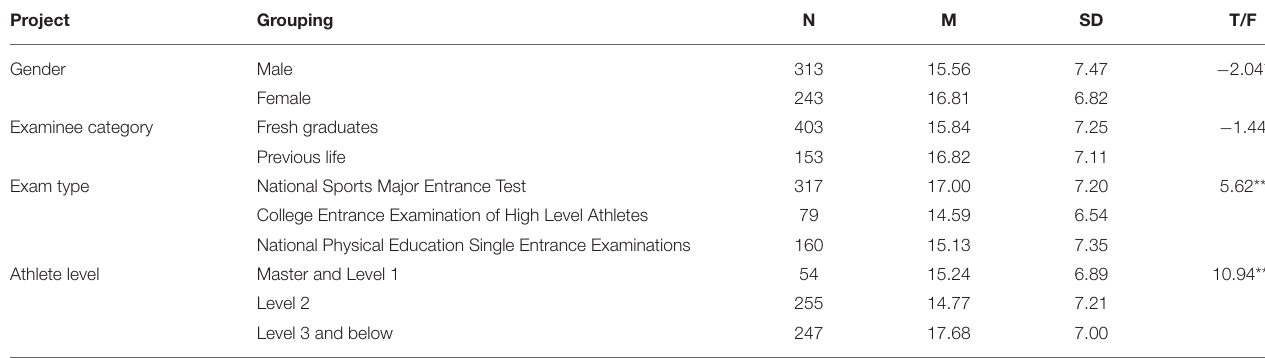
TABLE 1 | Analysis on the differences in test anxiety among student athletes with different demographic characteristics.